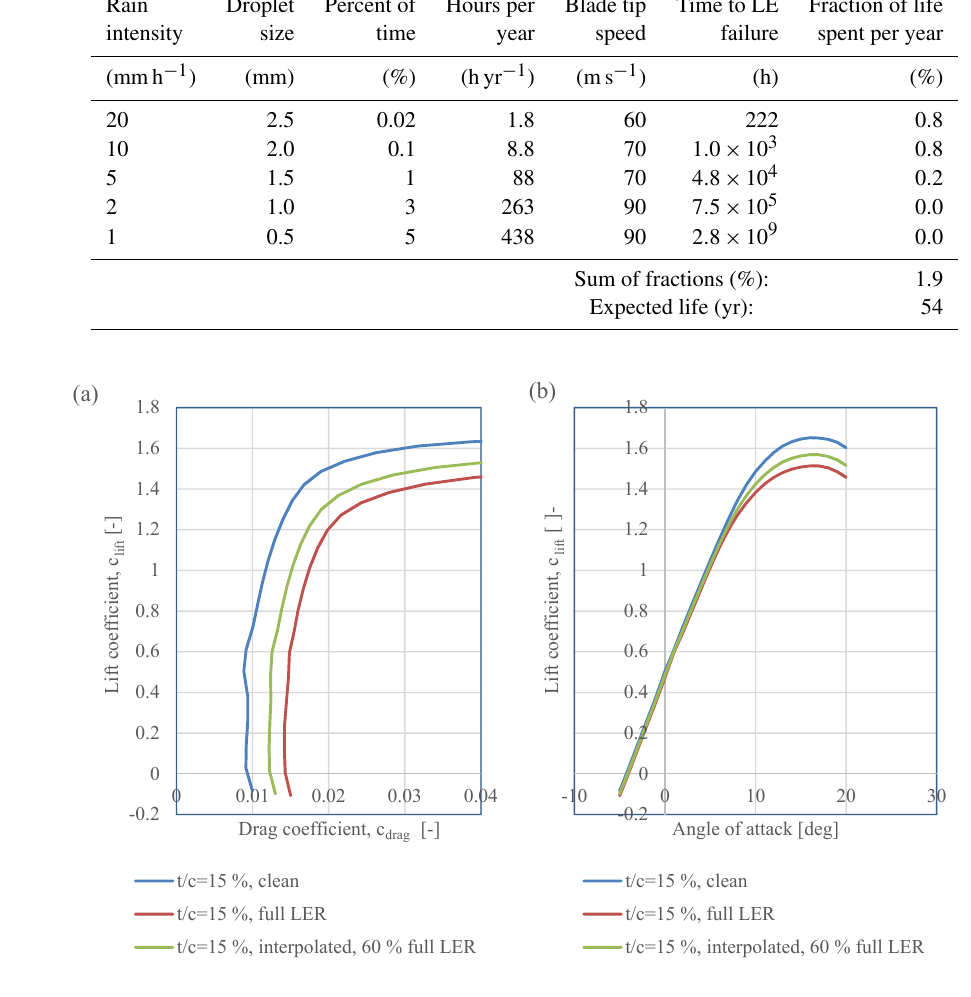
Figure 13. Airfoil characteristics of the outer part of the blade: blue – clean blade; red – full leading-edge roughness; green – 60% of full leading-edge roughness. (a) Lift coefficient, c lift , as a function of drag coefficient, c drag . (b) Lift coefficient, c lift , as a function of angle of attack